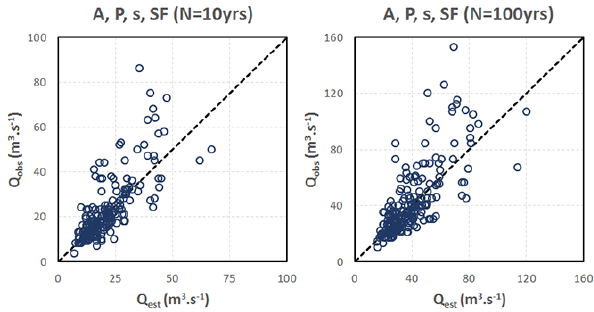
Figure 11. Scatterplot of observed versus estimated discharge val- ues for a combination of catchment area, maximum daily pre- cipitation total, average catchment slope and shape factor for T = 10 years (left panel) and T = 100 years (right panel).